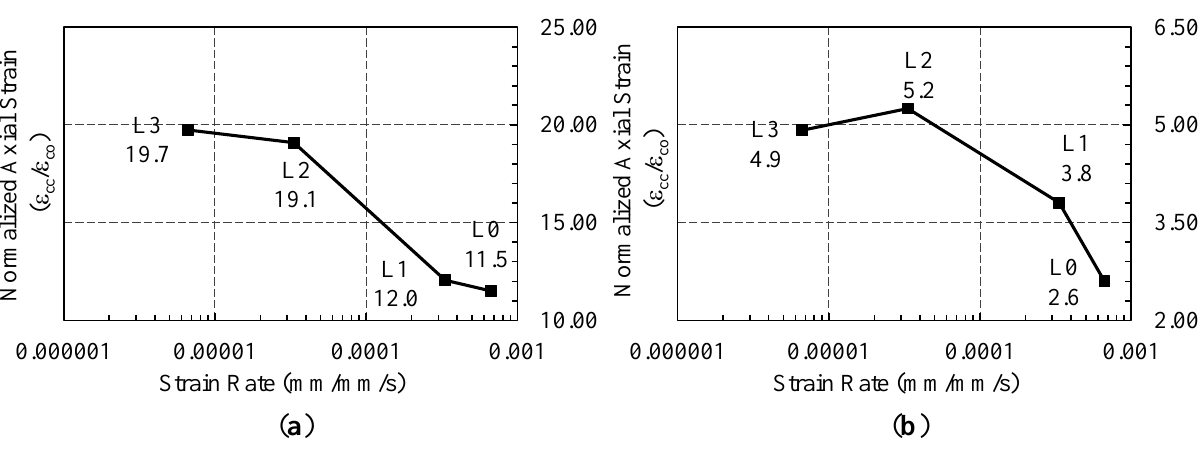
Figure 5. The variation of the ultimate axial strain with the strain rate. ( a ) Low-strength concrete. ( b ) Medium-strength concrete.